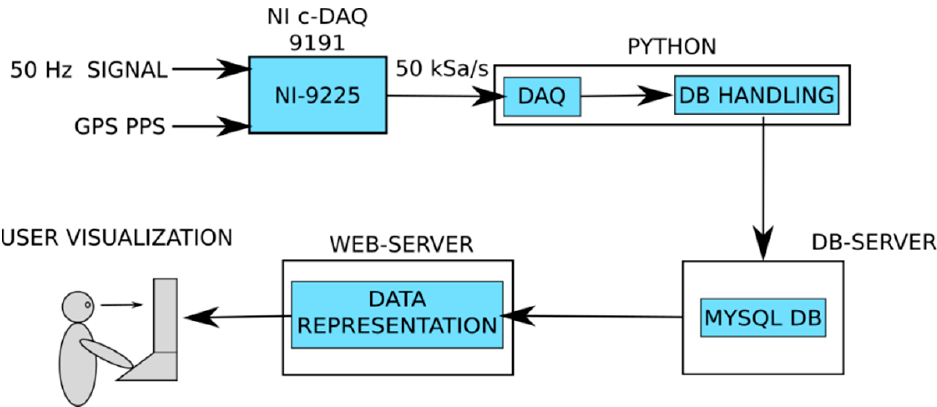
Figure 1. System block diagram. The c-DAQ module acquires the signals and transfers the infor- mation to online software. It saves information in the DB and then data is represented on an online viewer.